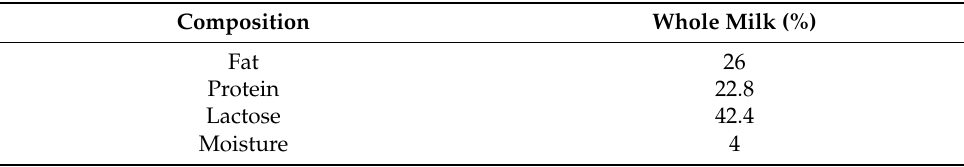
Table 2. Composition of the whole milk product.